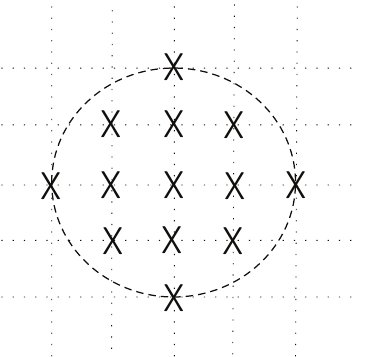
Figure 3: An appropriate search pattern is a circular area with a radius of two pixels.